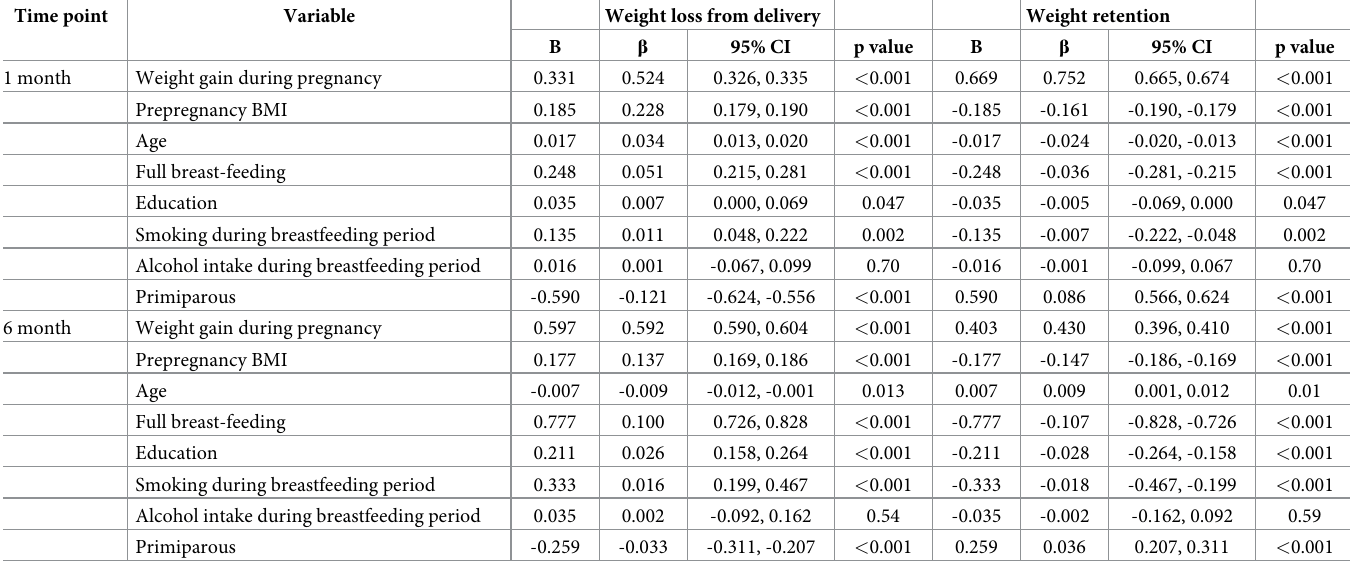
Table 4. Factors affecting postpartum maternal